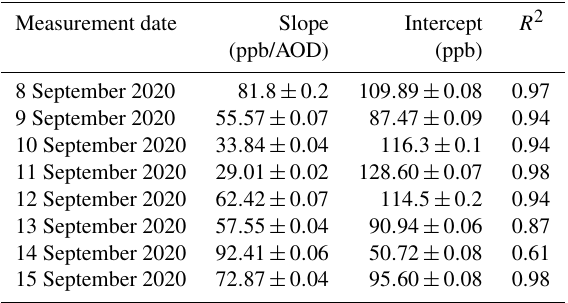
Table 1. Summary of the York linear fit of X CO and AOD for